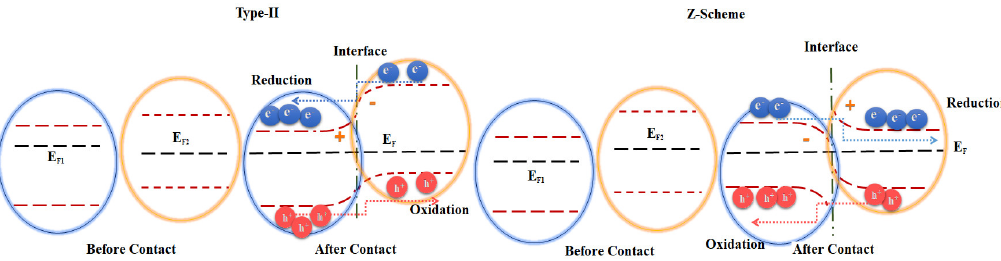
Figure 1. Schematic illustration of Type-II and Z-Scheme systems and their interfacial band bending under bandgap irradiation.